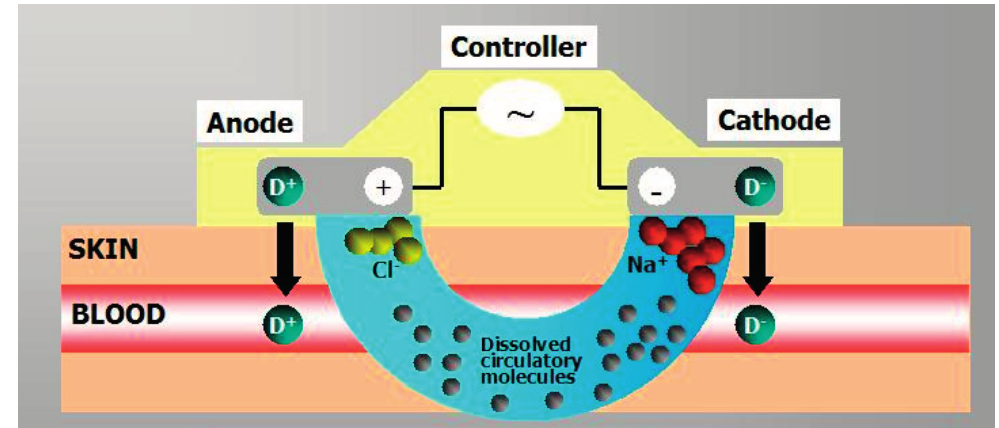
Figure 8. Schematic representation of an iontophoresis patch (Reprinted from [40] with permission. Copyright 2000 Elsevier).